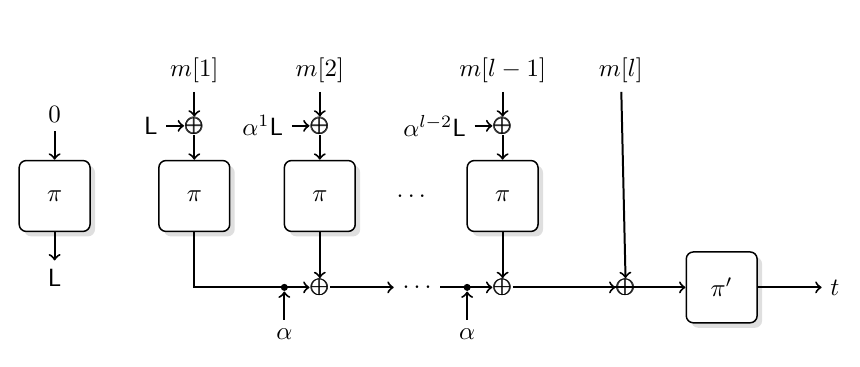
. Here α is a primitive element of the $ Perm